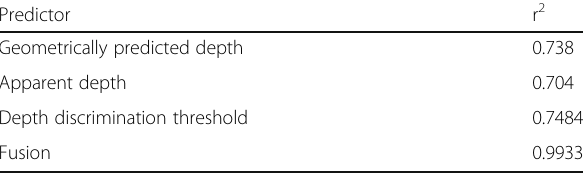
Table 1 Coefficients of determination for predicting depth realism